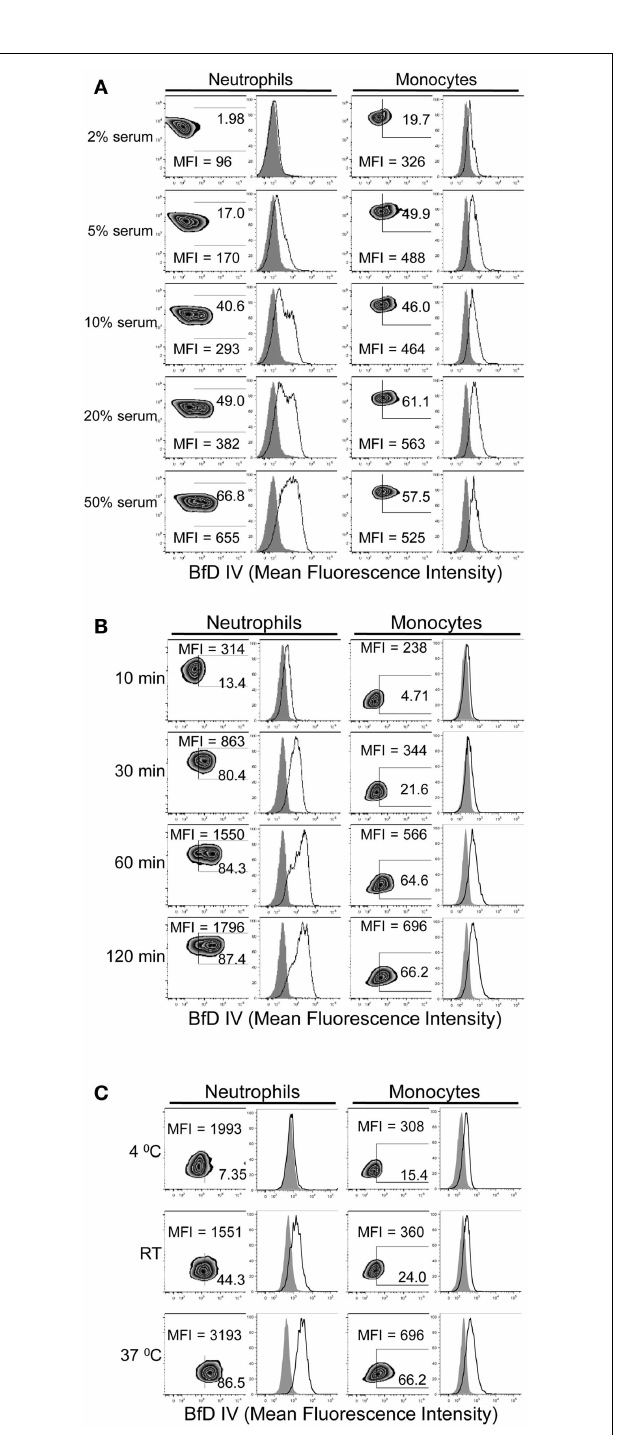
FIGURE 2 |Time, temperature, and serum-dependent binding of PGG β -glucan to human neutrophils and monocytes . PGG β -glucan binding to human neutrophils and monocytes was determined (A) in the presence of 2, 5, 10, 20, and 50% of serum, (B) at 10, 30, 60, and 120min, and (C) at RT, 4 and 37°C.The MFI and percentage of BfD IV positive cells were indicated in the zebra plots, and histogram shows PGG β -glucan binding (solid) in comparison to the vehicle-control (gray filled). Data shown in each of the conditions are representative of three independent experiments performed with cells obtained from three different